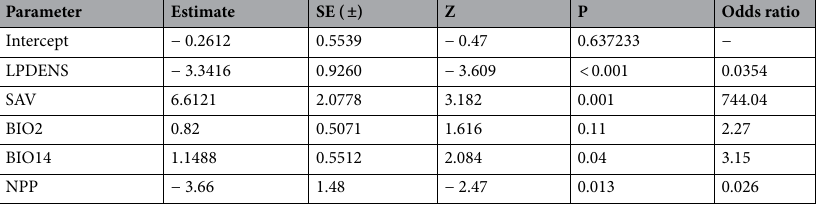
Table 3. Parameters of the best-fitting logistic regression model to assess northern tiger cat occurrence in the Amazon biome. LPDENS log-transformed ocelot density, SAV savanna, BIO2 mean diurnal range, BIO14 precipitation of driest month; NPP net primary